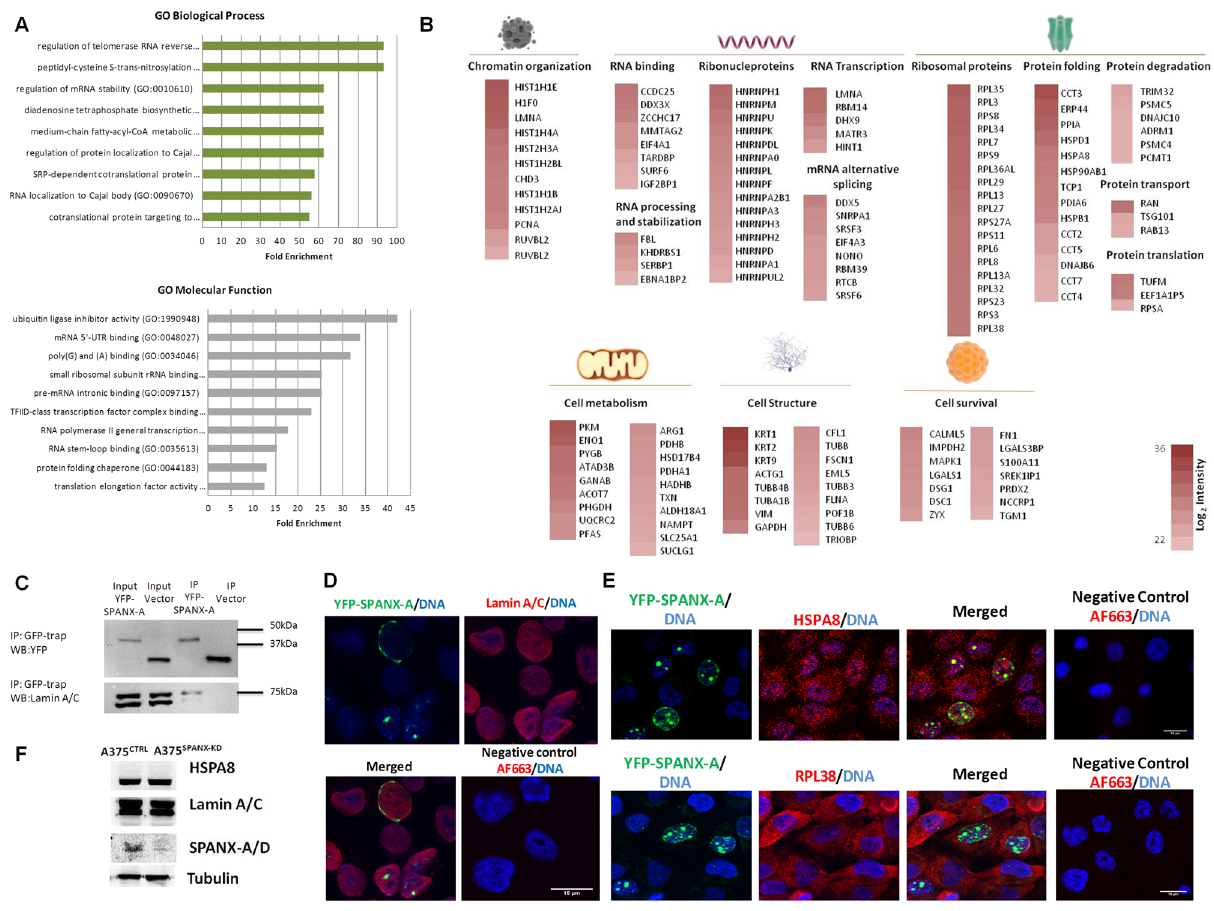
Figure 3. Study of the YFP-SPANX-A interactome A375 human melanoma cell line. (A) Gene Ontology based on the biological function and molecular processes of co-precipitated proteins together with SPANX-A in A375 melanoma cell line. The ten most enriched processes are shown. P < 0.05 (B) Representative scheme of principal putative interactors of SPANX-A based on their function. Information was obtained from Uniprot Database. Only the most representative functions are shown. Only the 19 most intense ribosomal proteins are shown (C) Validation of the interaction between YFP-SPANX-A and Lamin A/C by co-immunoprecipitation and western Blotting (N = 3). Crop from Supplementary Fig. S4. (D) Validation of the co-localisation between YFP- SPANX-A and Lamin A/C by immunofluorescence. YFP-SPANX-A is represented in green and Lamin A/C is shown in red. For the specificity of the secondary antiserum, the primary antibody was omitted. The nuclei were stained with Hoechst and are represented in blue. Scale bar 15 μm. (N = 3) Images were evaluated using ImageJ software (1.48v) (E) Co-localisation between YFP-SPANX-A and HSPA8, and YFP-SPANX-A and RPL38 by immunofluorescence . For the specificity of the secondary antiserum, the primary antibody was omitted. The nuclei were stained with Hoechst and are represented in blue. Scale bar 15 μm. (N = 3) Images were evaluated using ImageJ software (1.48v) ( F ) Expression of Lamin A/C and HSPA8 in A375 SPANX-KD cells. A375 SPANX-KD : Stable SPANX-A/D knockdown variant of the A375 human melanoma cell line; A375 CTRL : control cell line. N =